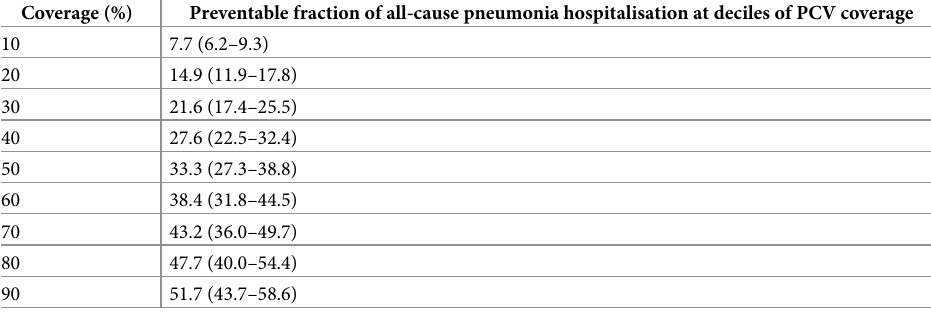
Table 7. Preventable fraction of all-cause pneumonia hospitalisations in undervaccinated children under 5 years at deciles of PCV coverage, New South Wales and Western Australia, 2001–2012. Coverage